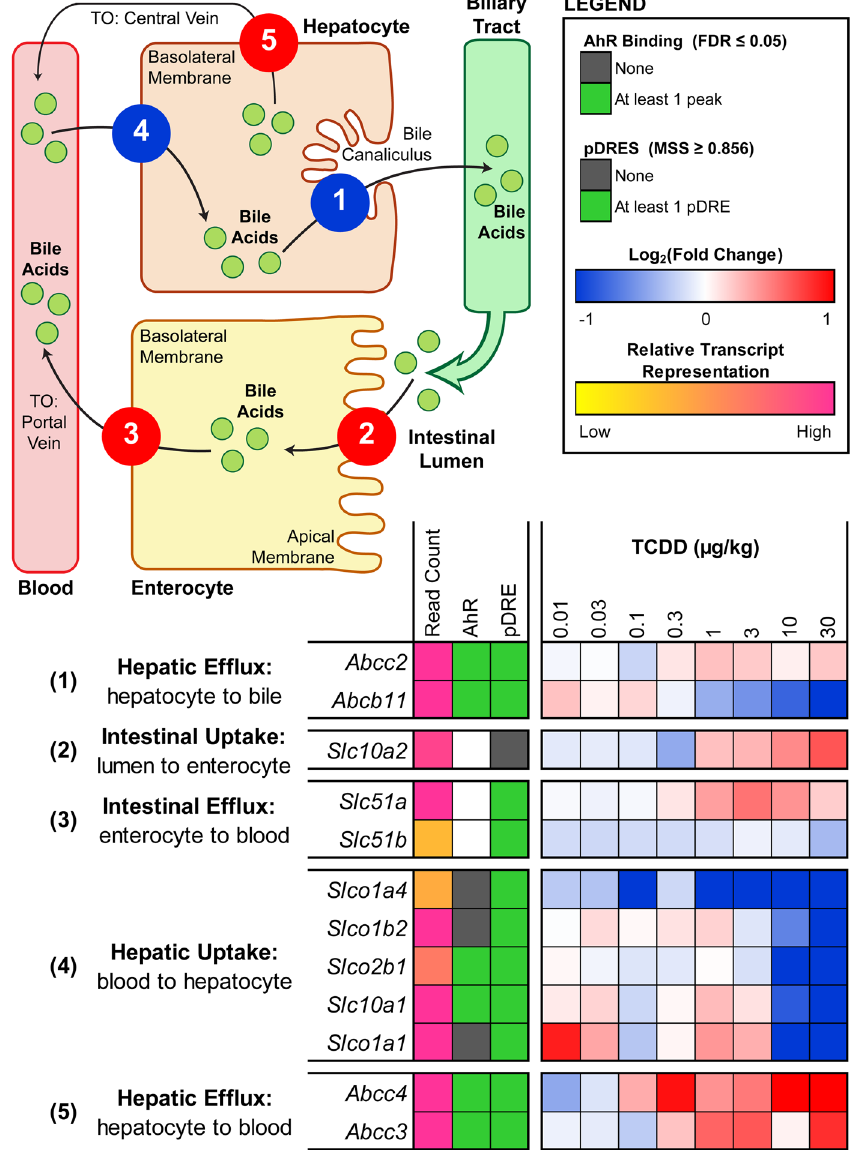
Figure 6. TCDD-elicited differential expression of bile acid transporters in the liver and ileum of male C57BL/6 mice orally gavaged with sesame oil vehicle or 0.01–30 µ g/kg TCDD every 4 days for 28 days. Color scale represents the log 2 (fold change) for differential gene expression relative to vehicle controls, as determined through RNA-Seq analysis (n = 3). The numeric labels to the left of the heat map correspond to the numbered transport functions in the pictorial representation, where the color of each function represents the overall direction of differential expression exhibited by the group of transporters involved (i.e. induced = red vs. repressed = blue). The presence of pDREs (MSS ≥ 0.856) and hepatic AhR enrichment peaks (FDR ≤ 0.05) at 2 h are shown as green boxes. Read count represents the raw number of aligned reads to each transcript indicating potential level of expression, where yellow represents a lower level of expression ( ≤ 500 reads) and pink represents a higher level of expression ( ≥